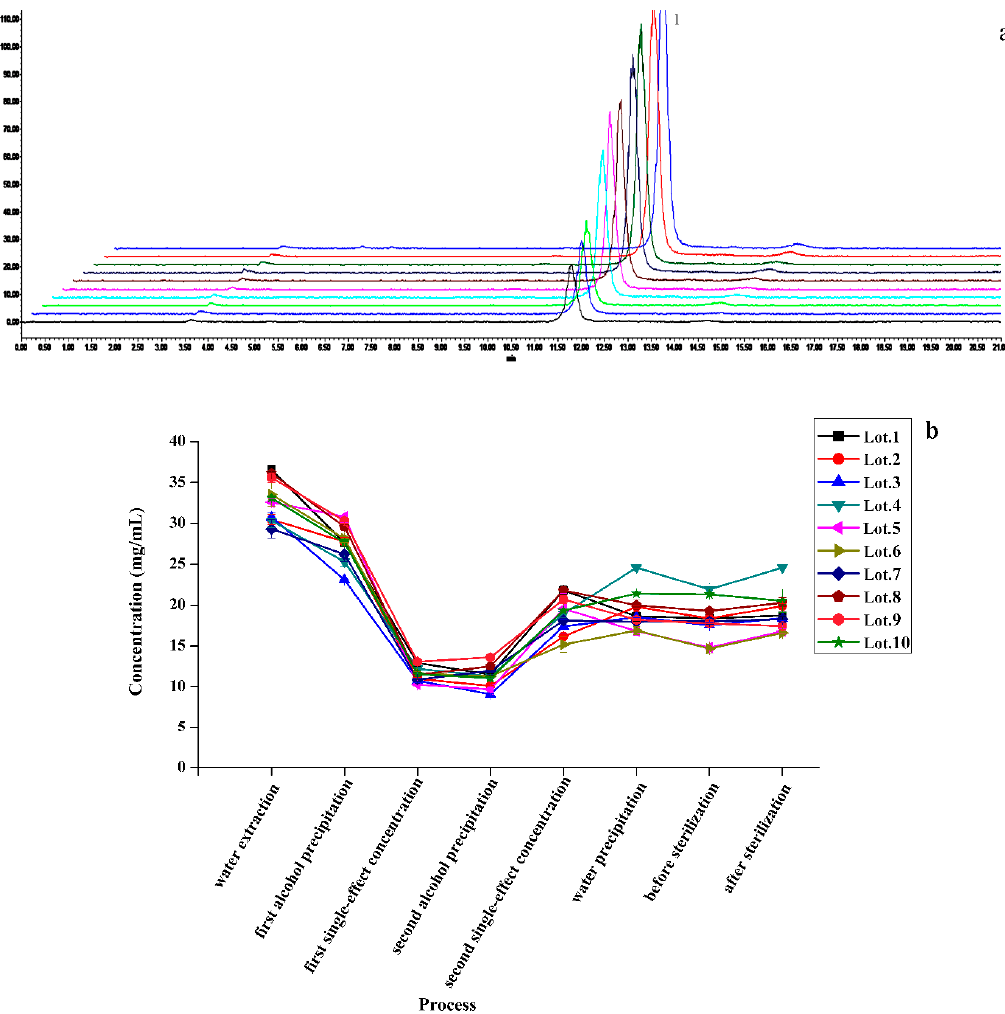
Figure 6. HPLC coupled with evaporative light scattering detector (HPLC-ELSD) chromatograms of ( a ) the sample solution of Ophiopogon japonicus extract intermediates including the processes of water extraction (three times), first alcohol precipitation, first single-e ff ect concentration, second alcohol precipitation, second single-e ff ect concentration, water precipitation, before sterilization, and after sterilization (1: Fru). The transfer process of ( b )